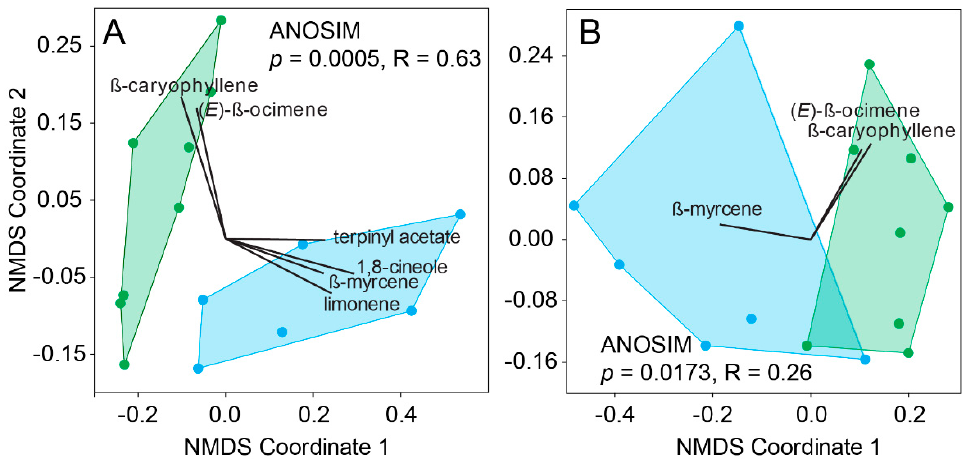
Figure 4. NMDS ordinations of the headspace chemical profiles of juvenile (in blue) and green (adult) foliage of the host C. eucalypti based on ( A ) the main constituents of the host headspace and ( B ) SSR-active compounds only .